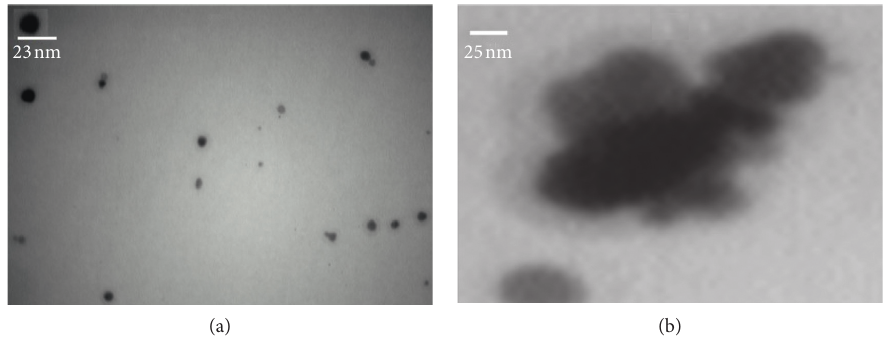
Figure 2: The TEM image analysis of the AgNPs (a) and AgNPs in the presence of zidovudine (b).